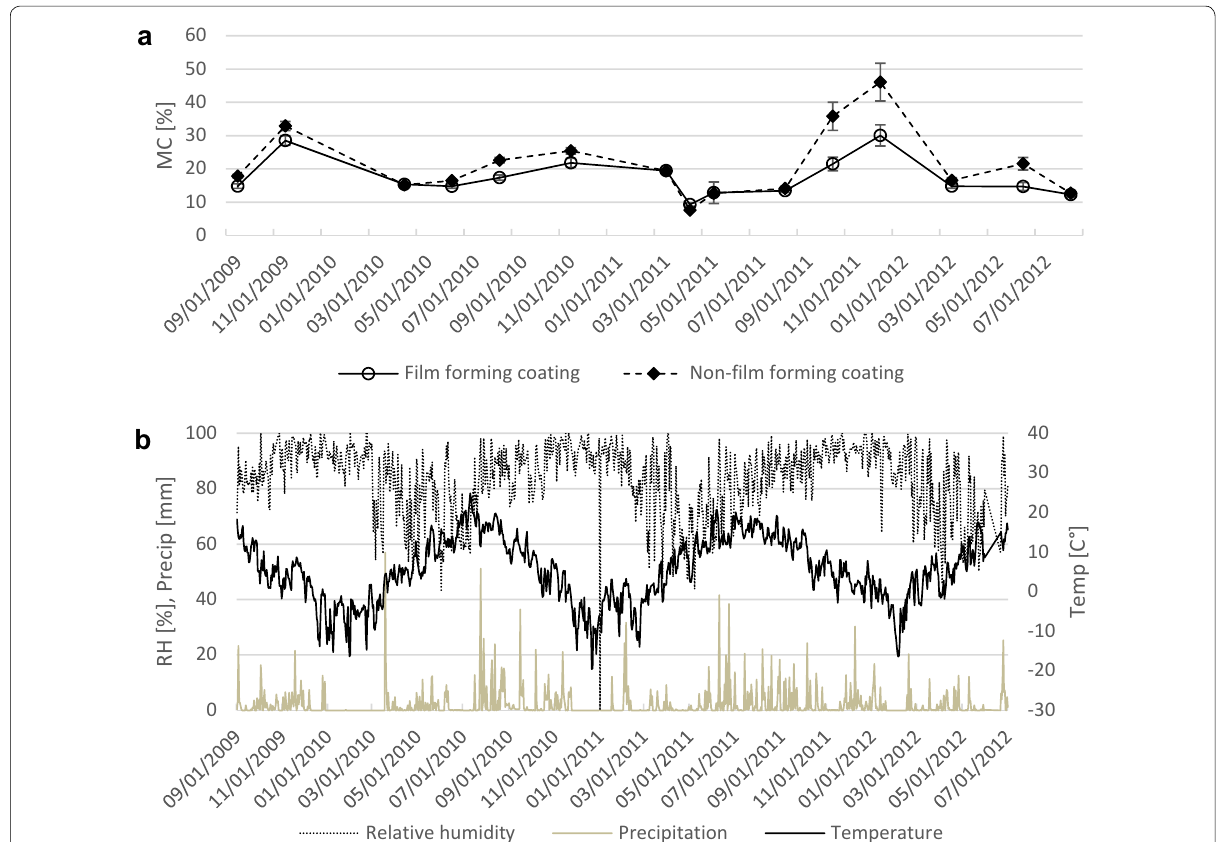
Fig. 1 a MC fluctuation for samples with the film-forming coatings (average of A, B and C) and the non-film-forming coating (D). The error bars represent the standard deviation of the values. b Relative humidity (RH), temperature and precipitation. A–D: coating systems described in Table